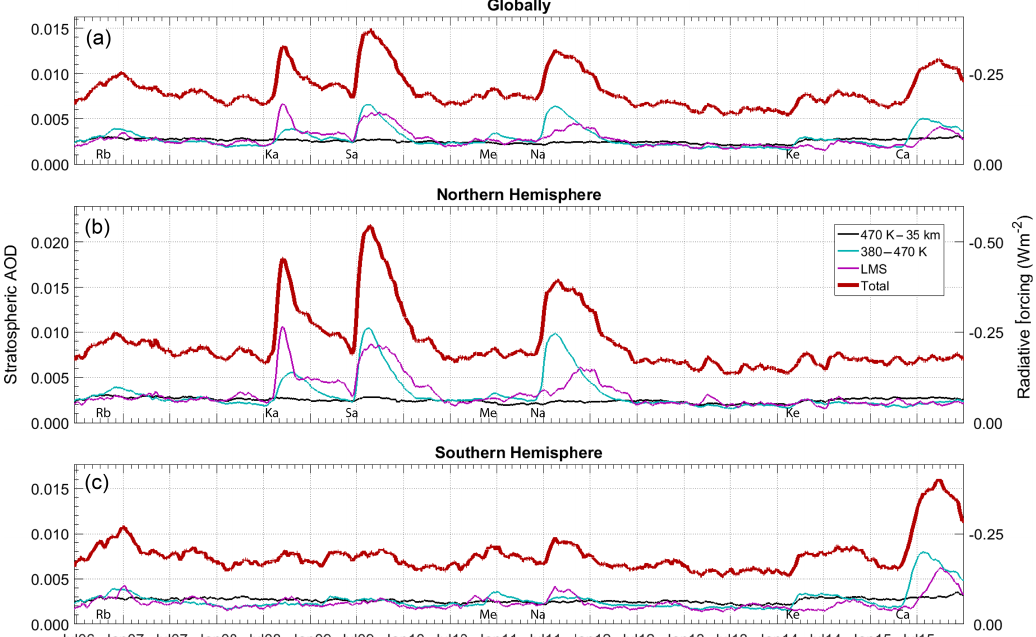
Figure 8. Temporal trends of the stratospheric AOD and radiative forcing for (a) the entire globe, (b) the Northern Hemisphere, and (c) the Southern Hemisphere. The lines mark the AOD of the LMS (magenta), altitudes between the 380 and 470K isentropes (cyan), altitudes above the 470K isentrope (black), and the entire stratosphere (thick red). Significant volcanic eruptions are indicated by their abbreviations. Note the reversed scale for the radiative forcing on the right y axis. Data were extrapolated to the polar regions and latitude weighted before